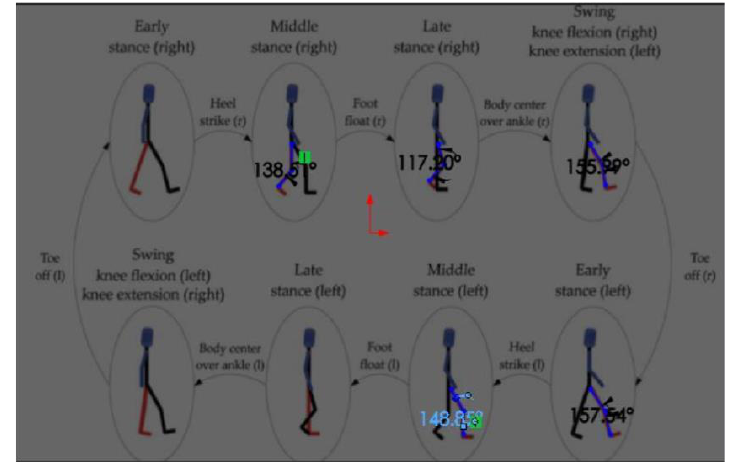
Figure 7. Angles for legs to walk